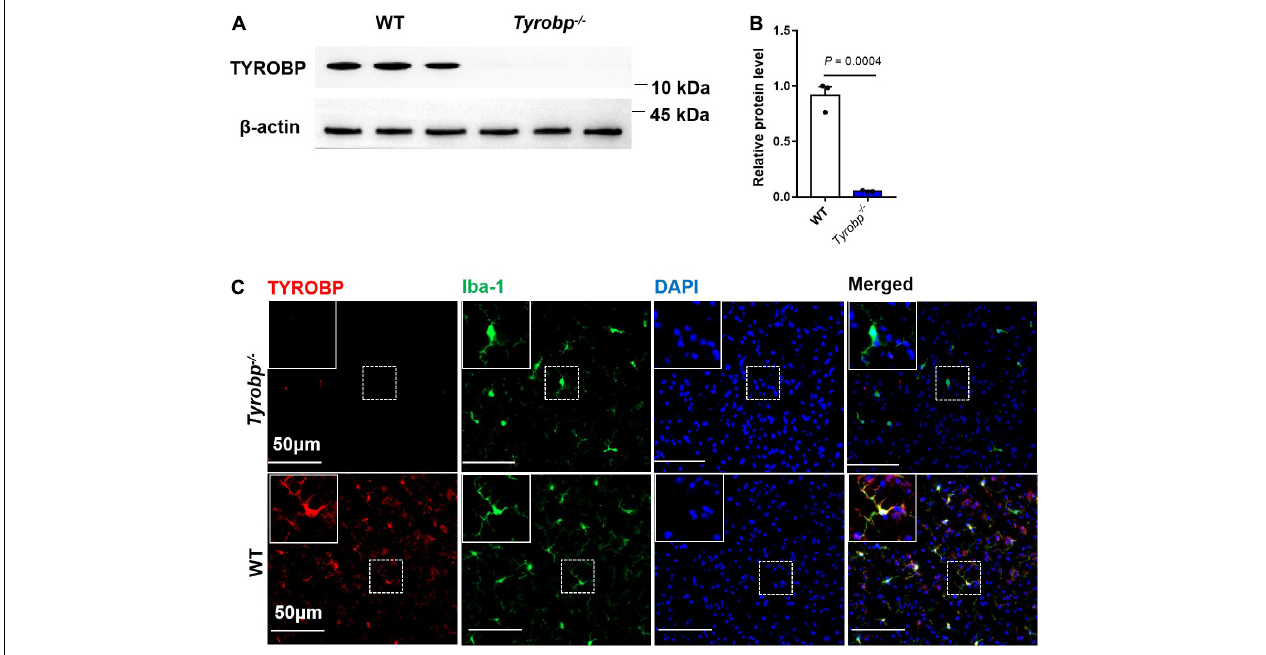
FIGURE 1 | Western blotting and immunofluorescence analysis of wild-type (WT) and Tyrobp − / − mice. (A,B) Western blotting and quantification of TYROBP in WT and Tyrobp − / − mice. (C) Immunofluorescence analysis of WT and Tyrobp − / − mice. Data in panel (B) are mean ± SEM. Statistical significance was calculated using Student’s t